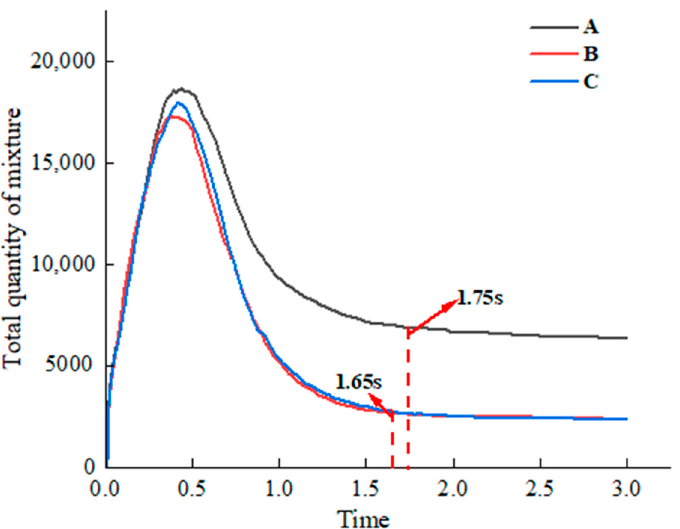
Figure 9. Grid bin group 1.